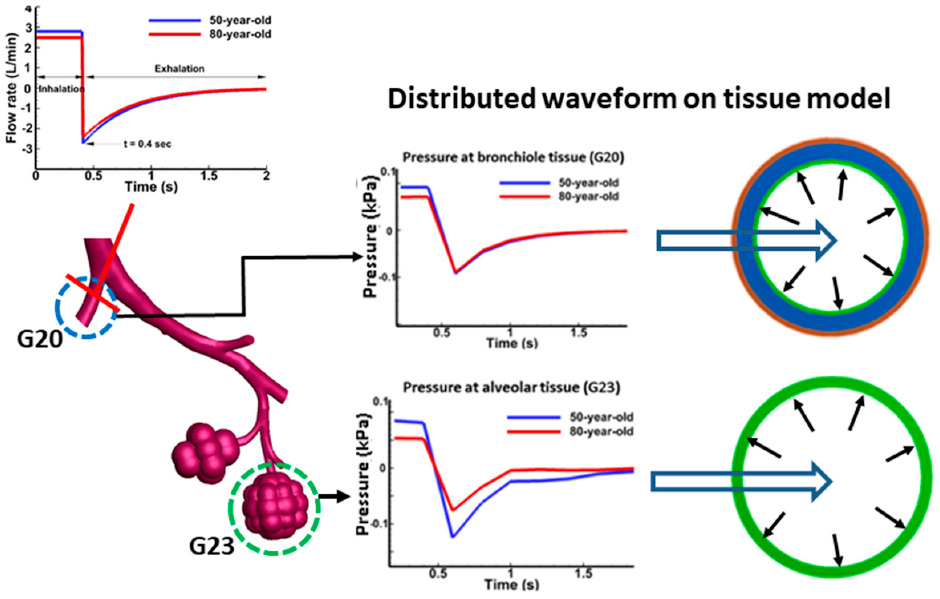
Figure 2. Pressure waveform for tissue model (G20 and G23) simulation. The pressure waveform was applied to tissue models for each age.